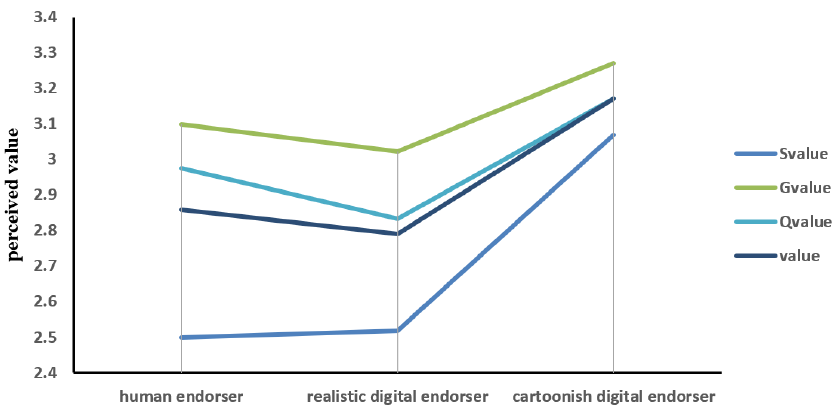
Figure 4. The relationship between digital endorser types and perceived value.